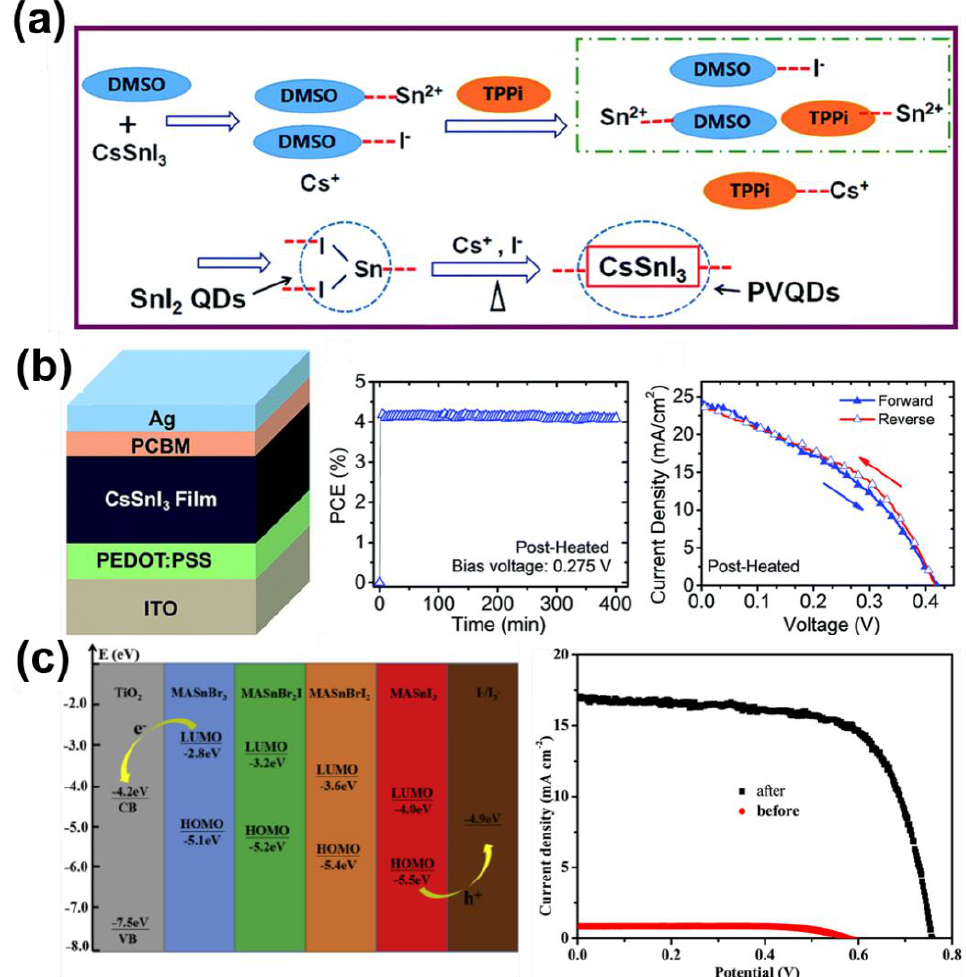
Figure 21. ( a ) The scheme of the production process of CsSnI 3 QD solution and the corresponding device structure. [109]. Copyright 2018 Clearance Center. ( b ) The steady-state measurement of the solar cells is based on the CsSnI 3 QD film continuously measured under AM1.5 illumination and the J-V measurements for CsSnI 3 QD solar cell devices. [109]. Copyright 2018 Clearance Center. ( c ) Energy levels distribution of the device and characteristic J-V curves for MASnBr 2 I QDs-sensitized solar cells before and after tailored with the trace of N719. [110]. Copyright 2018